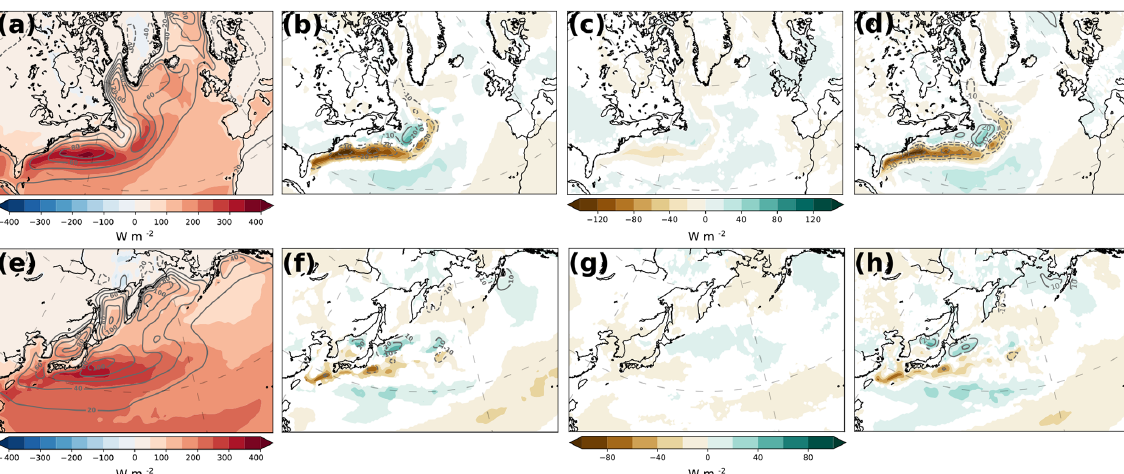
Figure 7. (a) Climatological latent (shading, Wm − 2 ) and sensible heat fluxes (contours, Wm − 2 ) for the North Atlantic for CNTL. (b) Statistically significant ( > 95%, based on the t test) difference of the heat flux climatologies between SMTHG and CNTL (SMTHG–CNTL) for latent (shading) and sensible heat fluxes (grey contours, interval: 10Wm − 2 , zero contour omitted). (c, d) As panel (b) but separated for fluxes within (c) and outside (d) a radius of 750km around a cyclone centre. (e–h) As panels (a) – (d) but for the North